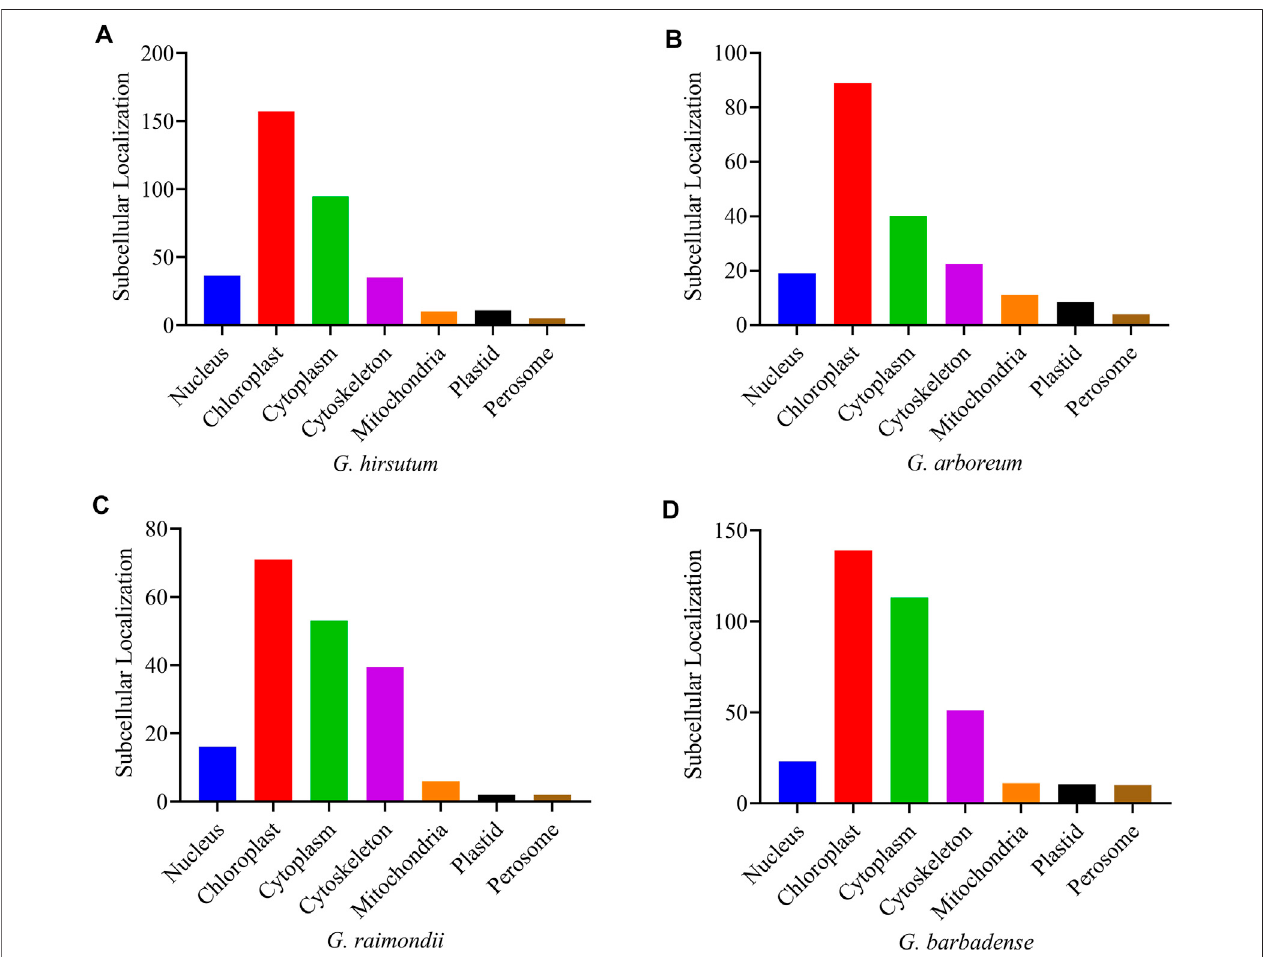
FIGURE 5 | Subcellular localization prediction of the PFK genes of Gossypium species (A) G. hirsutum; (B) G. arboreum; (C) G. raimondii; (D) G. barbadense.